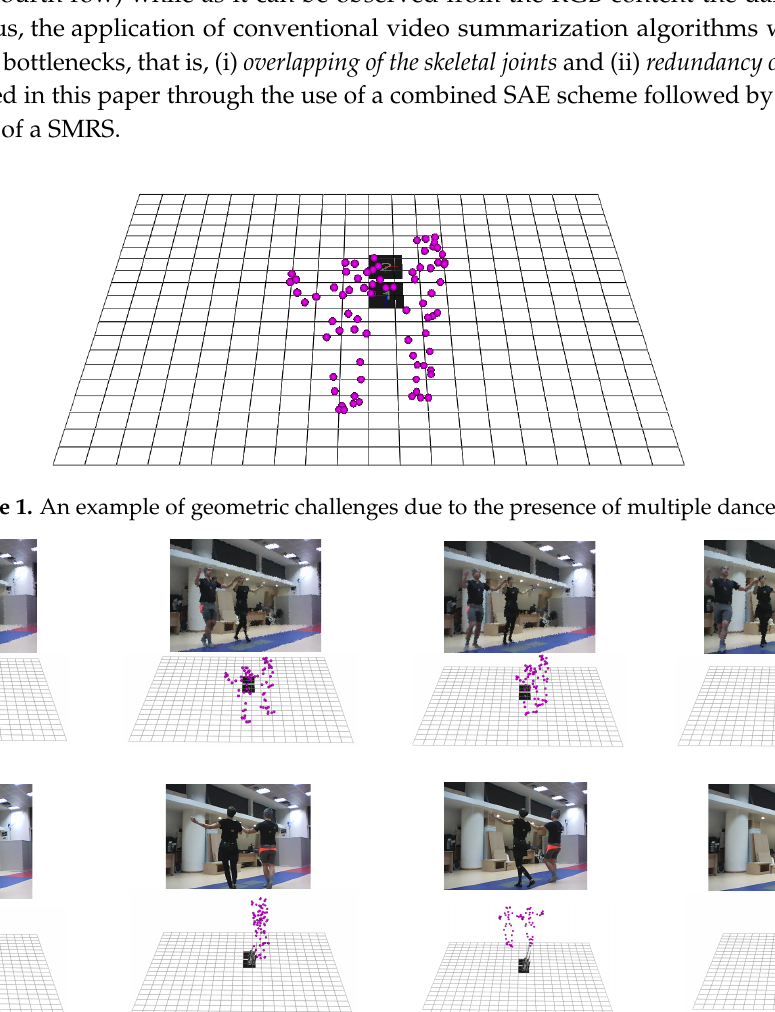
Figure 2. This visual sequences depict the motion capturing process. 3D skeletal data are obtained by the VICON motion capturing system ( second and fourth row ) and the respective RGB content ( first and third row ). This figure refers to Makedonikos dance sequence, executed by two dancers